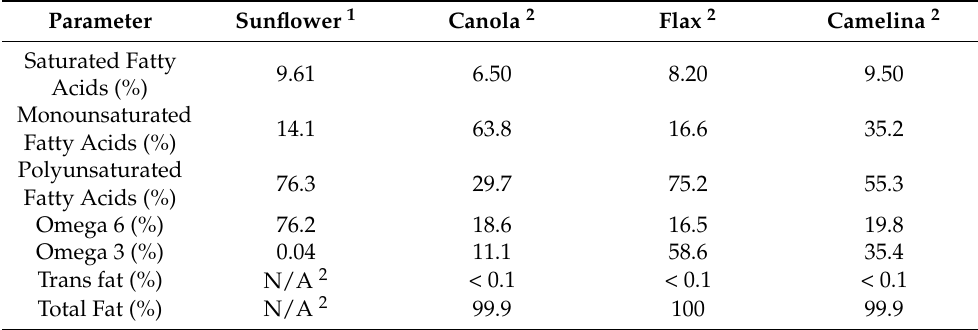
Table 2. Fatty acid profile of camelina oil, canola oil, flax oil, and sunflower